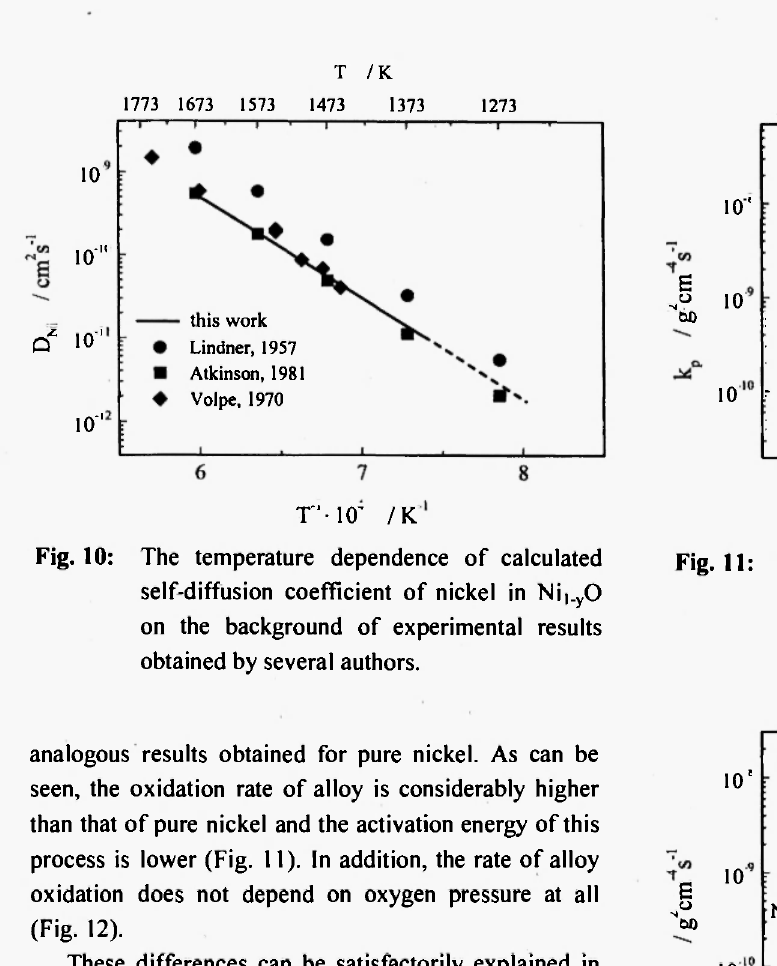
Fig. 12: The pressure dependence of the oxidation rate of the Ni-l%Cr alloy for several